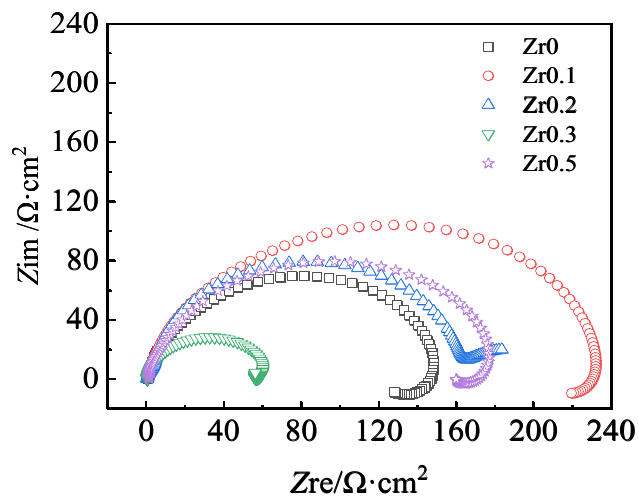
Figure 6. The Nyquist curves ( Z im versus Z re) of AlCoCrFeNiZr x (x = 0, 0.1, 0.2, 0.3, and 0.5) alloys in a 0.5 M H 2 SO 4 solution. For a better explanation of the corrosion behavior of the AlCoCrFeNiZr x alloys in 0.5